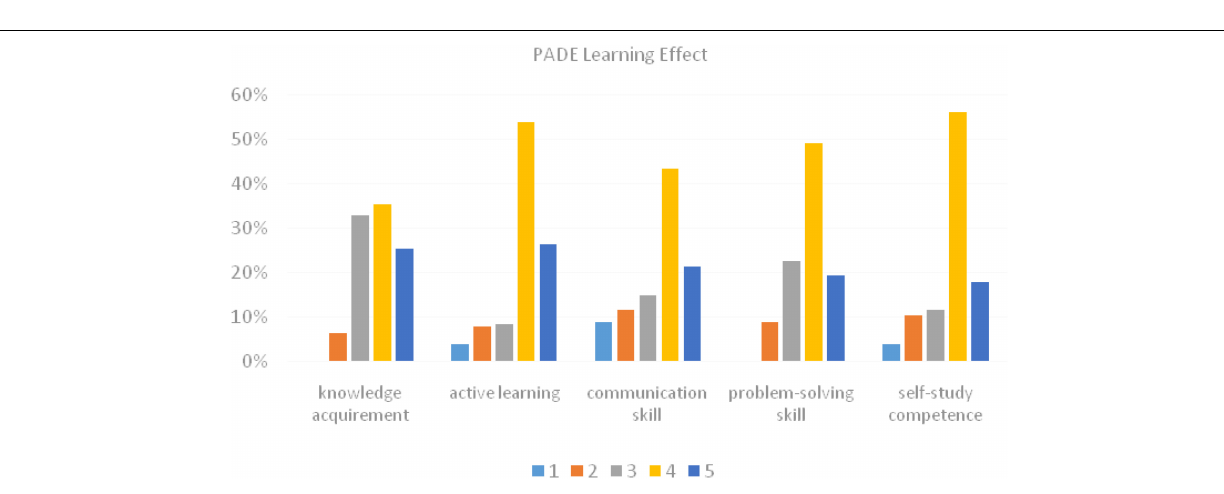
FIGURE 4 | Percentage of the PADE learning effect: 1 – strongly disagree; 2 – disagree; 3 – neutral; 4 – agree; 5 – strongly agree.